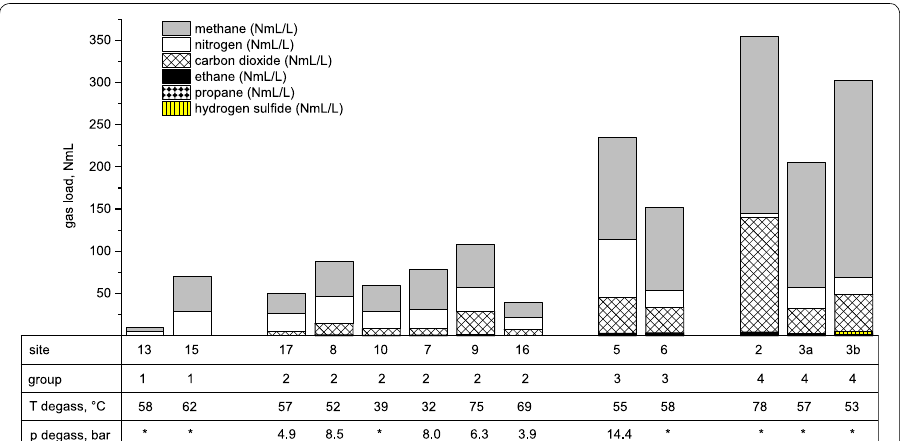
Fig. 2 Normalized gas load and gas composition with indication of degassing temperature during sampling (p 1.0 bar). The degassing pressure is calculated for the production temperature given as p degass. *No = data for